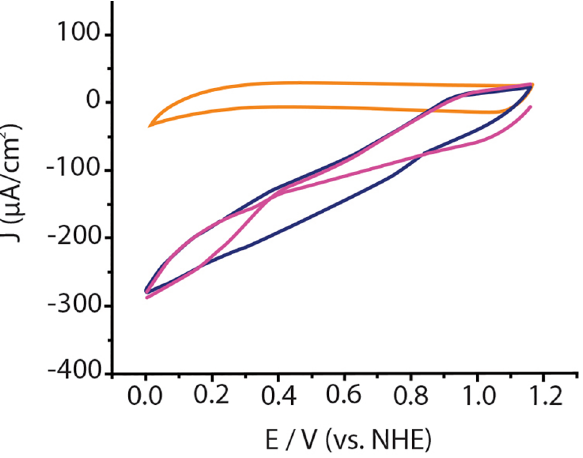
Fig 5. CVs of immobilized Mv BOD on SPGE. Orange lines in absence of O 2. Purple lines first scan; blue lines second scan. Scan rate 5 mV/s.